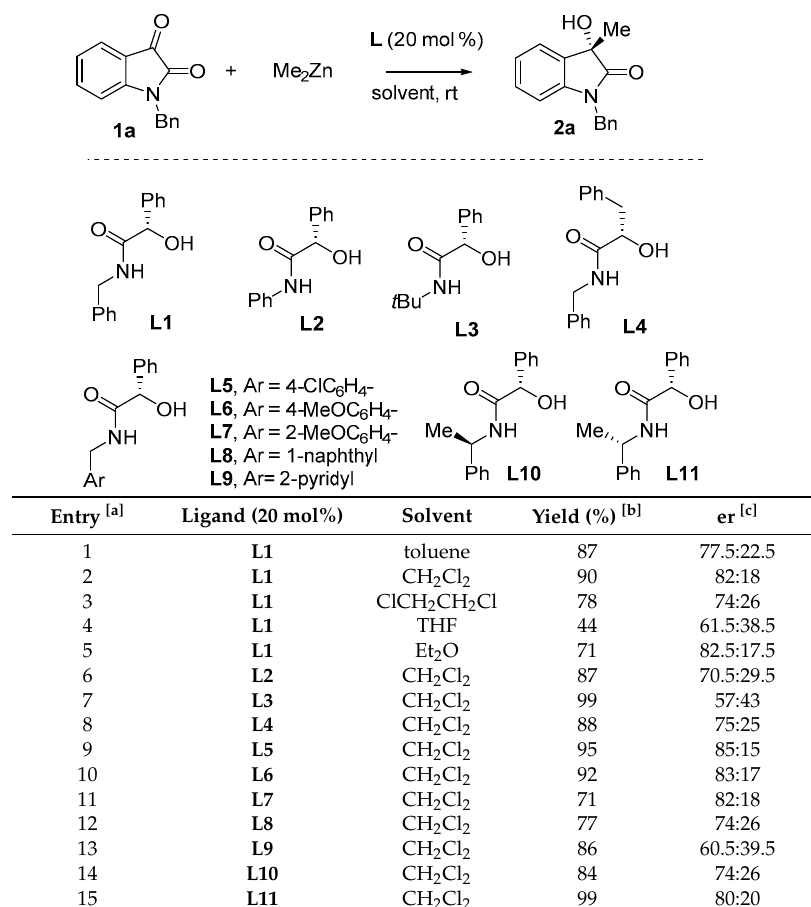
Table 1. Optimization of the reaction conditions.